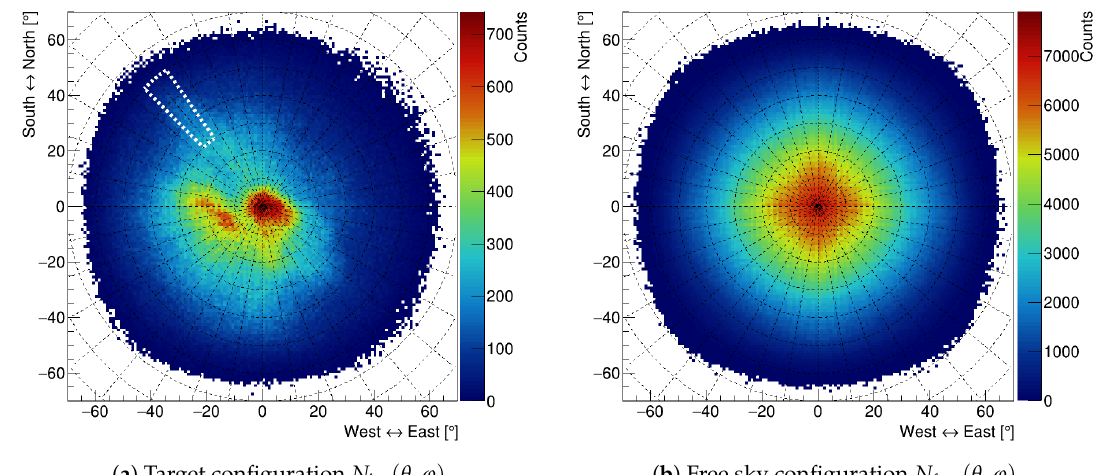
Figure 4. Track angular distribution N ( θ , ϕ ) for the two different configurations. All the maps are drawn using the polar reference frame: in the center there is the vertical direction, the circles correspond to directions with the same zenith angle θ and the lines indicate directions with the same azimuth angle ϕ (both are represented with a 10 ◦ step). The white dotted region in the target configuration will be considered below for a quantitative analysis (see also Figure